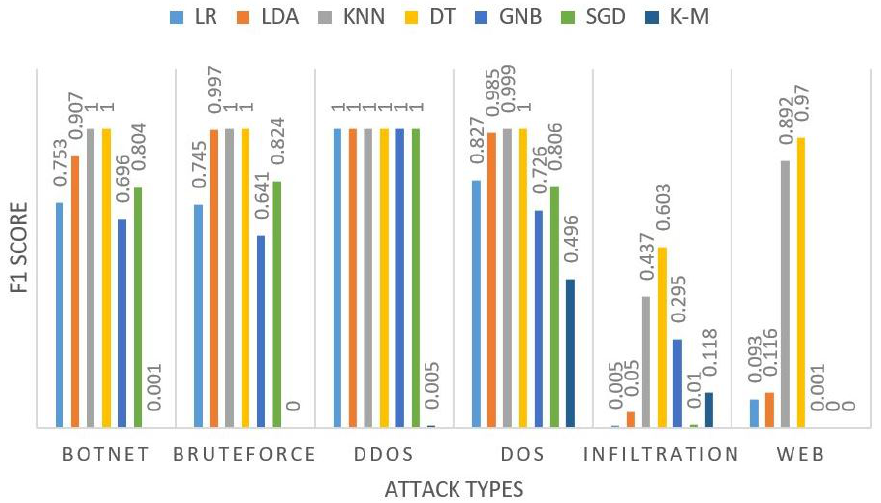
Figure 14. F1 Score of different ML approaches based on various attack types. Thus, the overall performance of DT classifier is better than any other ML classifier for ML based IDS. It shows the maximum percentage for detecting normal packets correctly followed by KNN. There was no considerable difference between KNN and